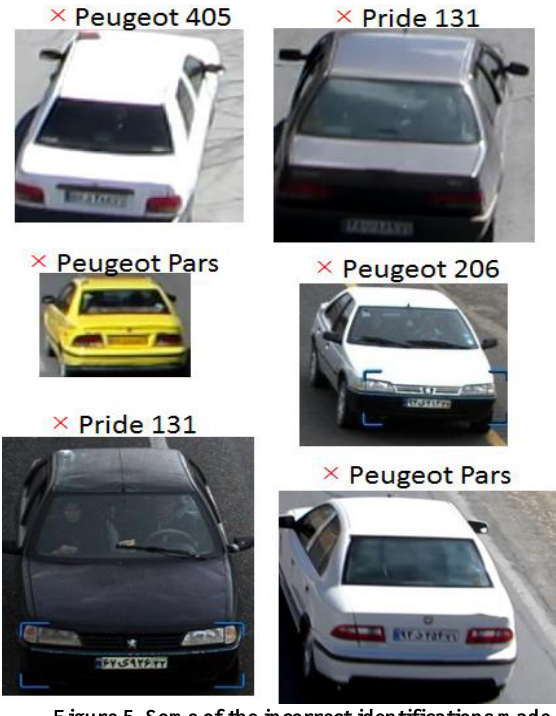
Figure 5. Some of the incorrect identifications made by the BOW